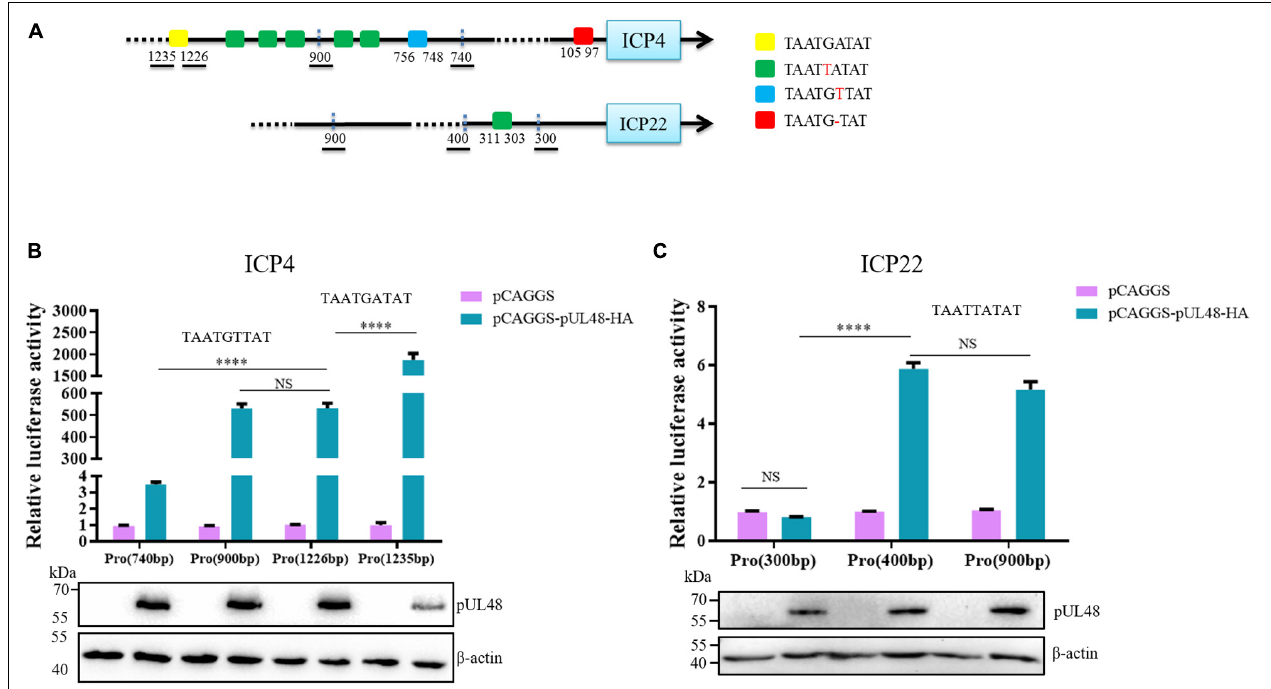
FIGURE 3 | The regulatory effects of pUL48 on ICP4 and ICP22 promoters containing different components. (A) Initial upstream cis -element sequence analysis of ICP4 and ICP22. Different colored squares represent different possible sequences of cis -elements. (B) The regulation of pUL48 on ICP4 promoter containing different elements. (C) The regulation of pUL48 on ICP22 promoter containing different elements. ICP4-Pro (740 bp)-Luc, ICP4-Pro (900 bp)-Luc, ICP4-Pro (1,226 bp)-Luc, ICP4-Pro (1,235 bp)-Luc, ICP22-Pro (300 bp)-Luc, ICP22-Pro (400 bp)-Luc, ICP22-Pro (900 bp)-Luc, pCAGGS, pCAGGS-pUL48-HA, and pRL-TK were cotransfected into DEF. At 24 h after transfection, cell samples were collected, and the activity of each promoter was detected by the dual-luciferase reporting system. pCAGGS-pUL48-HA was transfected into DEF. At 24 h after transfection, cell protein samples were collected for Western blot analysis. Student’s t -test was used to analyze the differences of the two groups. NS was not significant, ∗∗∗∗ p < 0.0001.